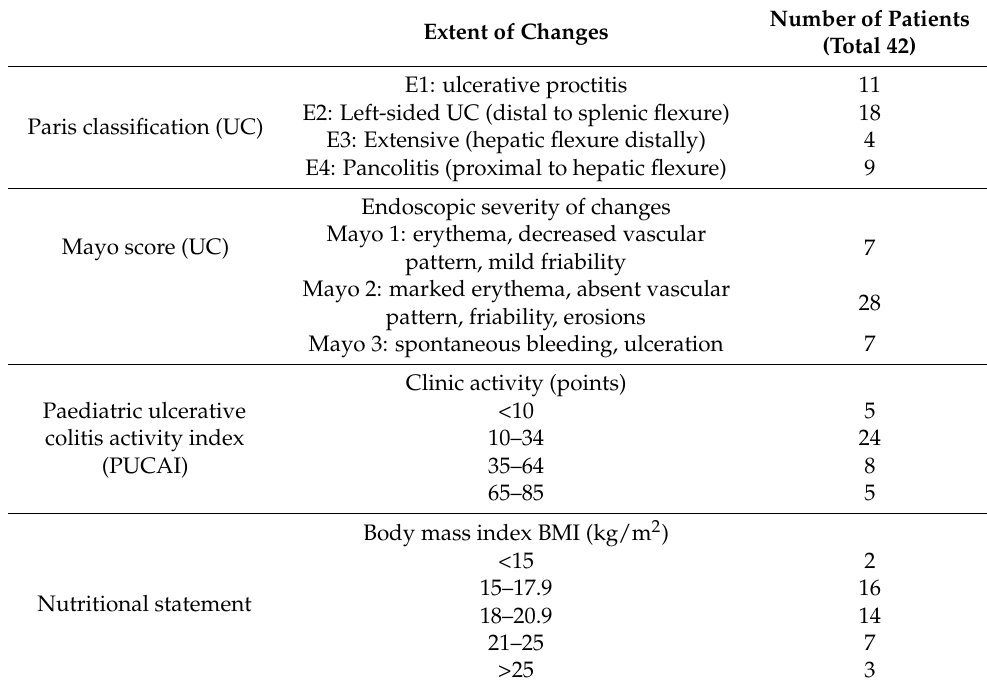
Table 2. Location, nutritional statement, endoscopic, and clinic activity at the time of diagnosis of